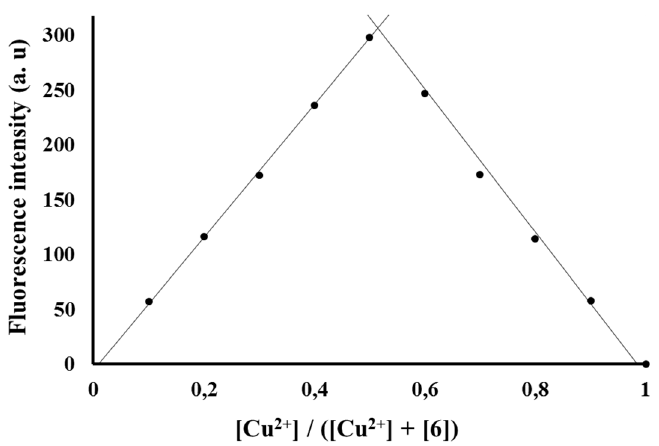
Figure 7. Changes in the emission spectra of ( a ) monomer 6 (5 × 10 − 12 M) and ( b ) compound 7 (3 × 10 − 8 M) in acetonitrile upon the addition of Cu 2+ aliquots (monomer 6: 3 × 10 − 5 M Cu 2+ ; compound 7 : 1.3 µM Cu 2+ ). Excitation was performed at 395 nm.